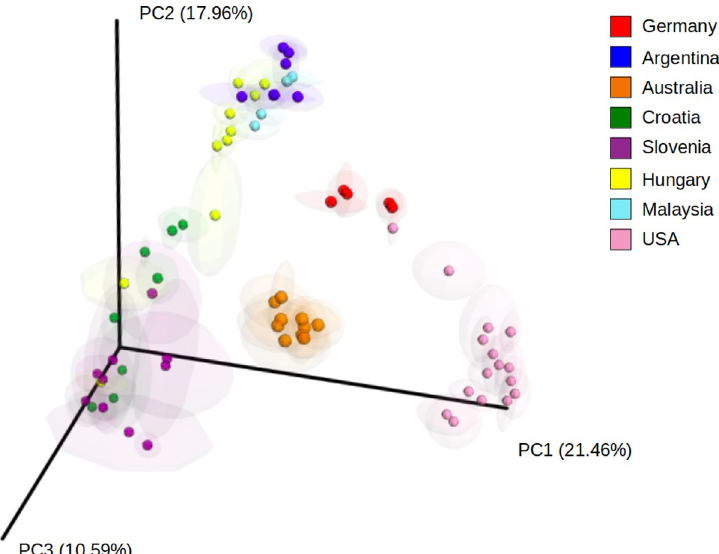
Fig 1. Principal coordinate analysis (PCoA) of unweighted UniFrac distances. Chicken GIT microbiota samples from different geographic locations were designated as AUS: Australia, ARG: Argentina, CRO: Croatia, GER: Germany, HUN: Hungary, MAL: Malaysia, SLO: Slovenia and USA: United States.